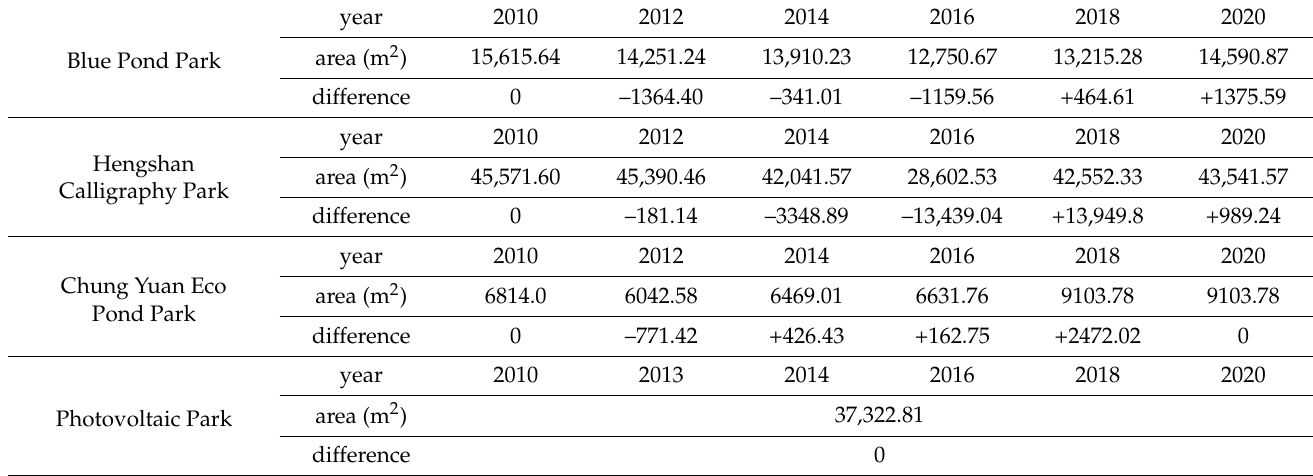
Figure 14. The illustration of the two types of boundary: ( a ) the projection of the 3D point cloud; ( b ) the Blue Pond in the yellow color boundary and 2016 Google Earth Pro® image in the blue color boundary; ( c ) blue boundary: 4635.26 m 2 ; ( d ) yellow boundary: 5332.86 m 2 ; ( e ) pink boundary: 697.6 m 2 in 15% tolerance. Table 3. Annual alternations of pond water area based on satellite images.